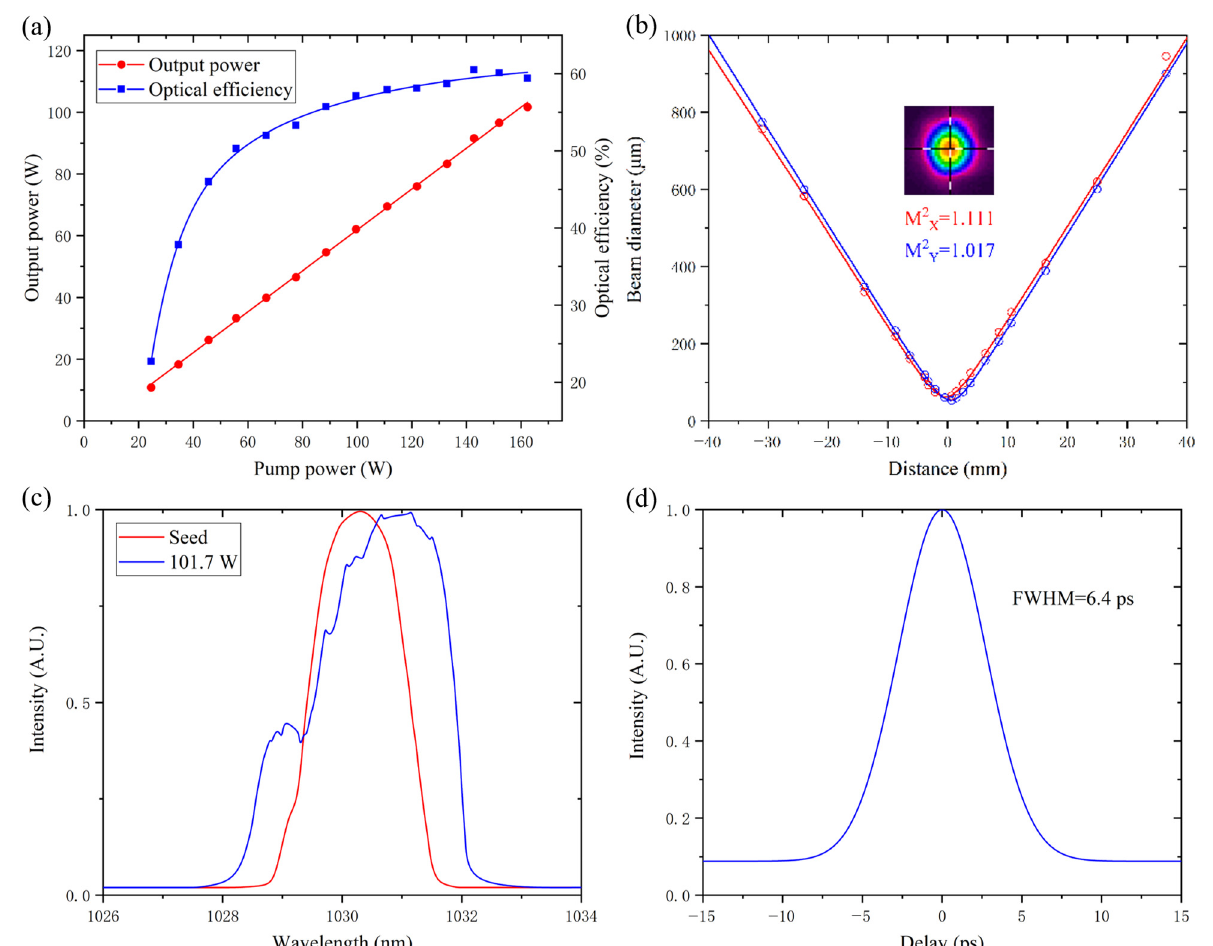
Figure 11. Output power and optical efficiency as a function of pump power ( a ); M 2 measurement at 101.7 W ( b ); optical spectrum from seed and 101.7 W output ( c ); autocorrelation signal of output pulses at 101.7 W ( d ).